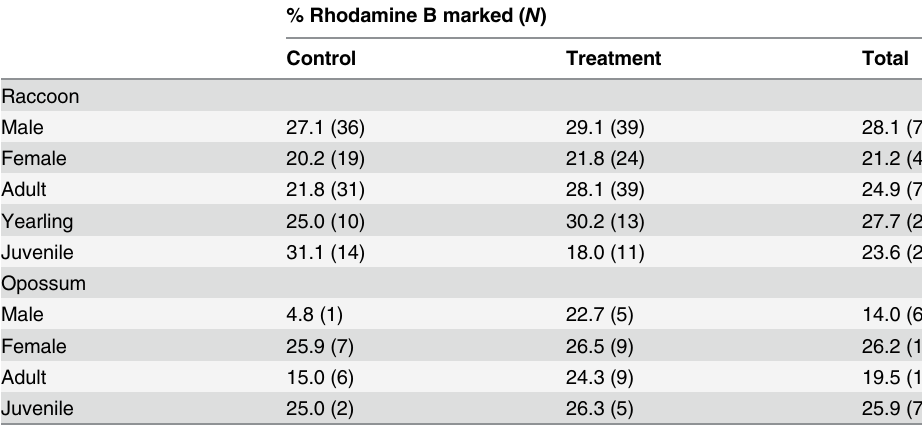
Table 3. Percent of population marked with Rhodamine B following placebo baiting by age and sex class in control and treatment sites for raccoons and opossums (actual numbers of individuals in